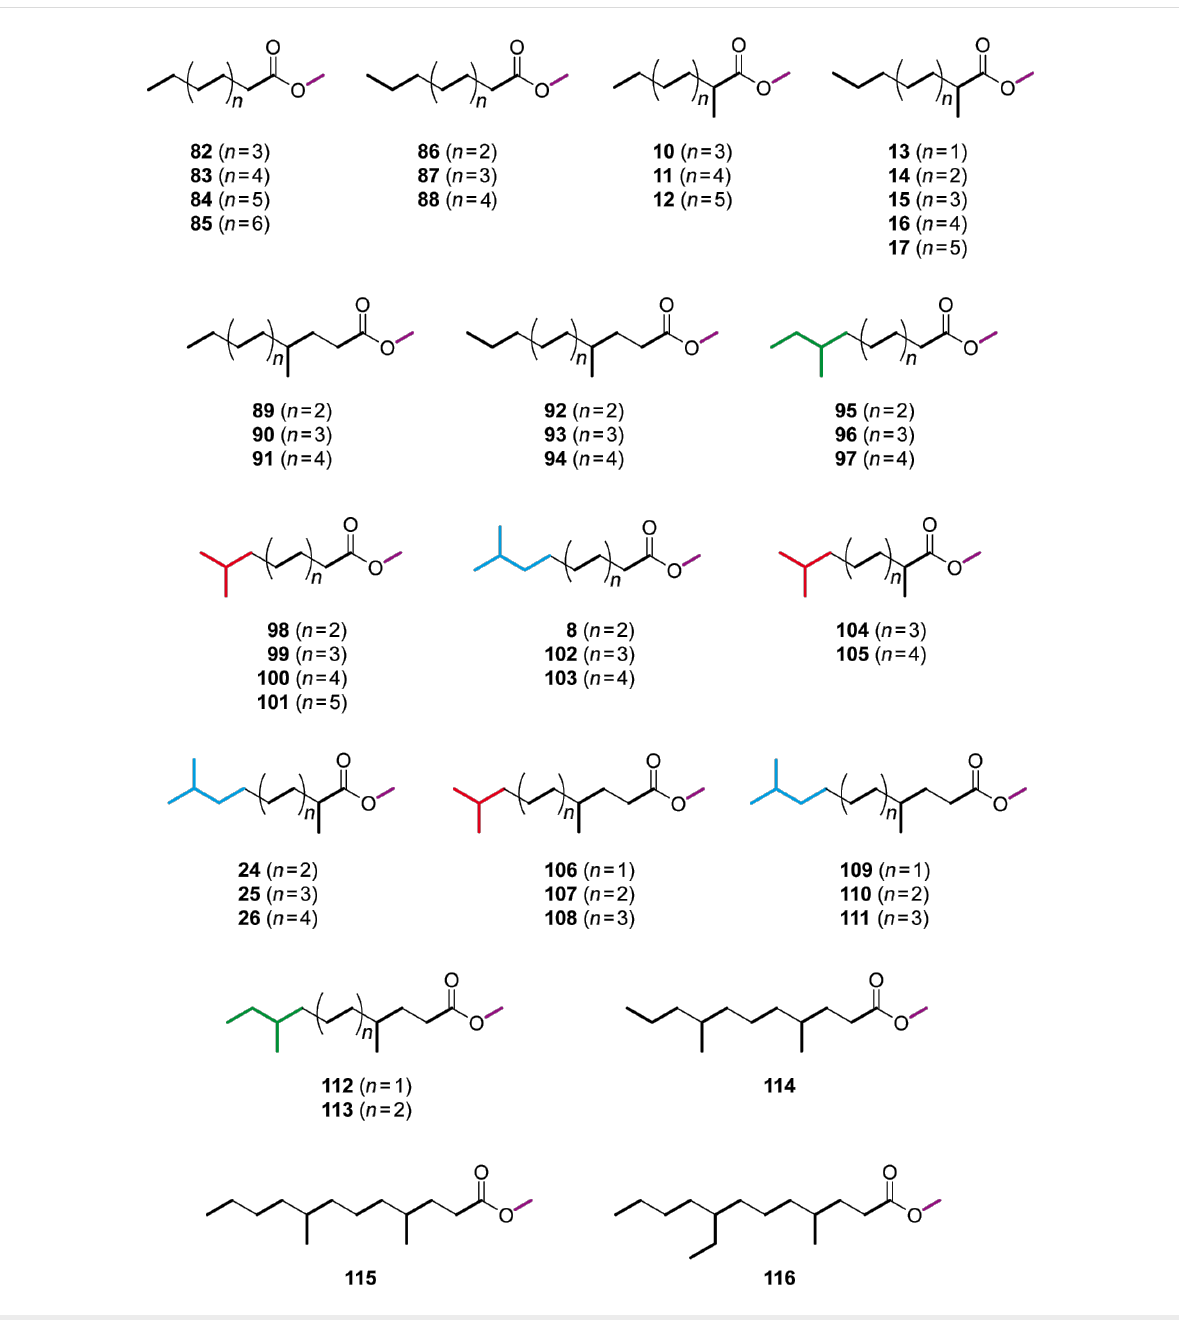
Figure 4: FAMEs identified in the headspace extracts from M. aurantiaca .